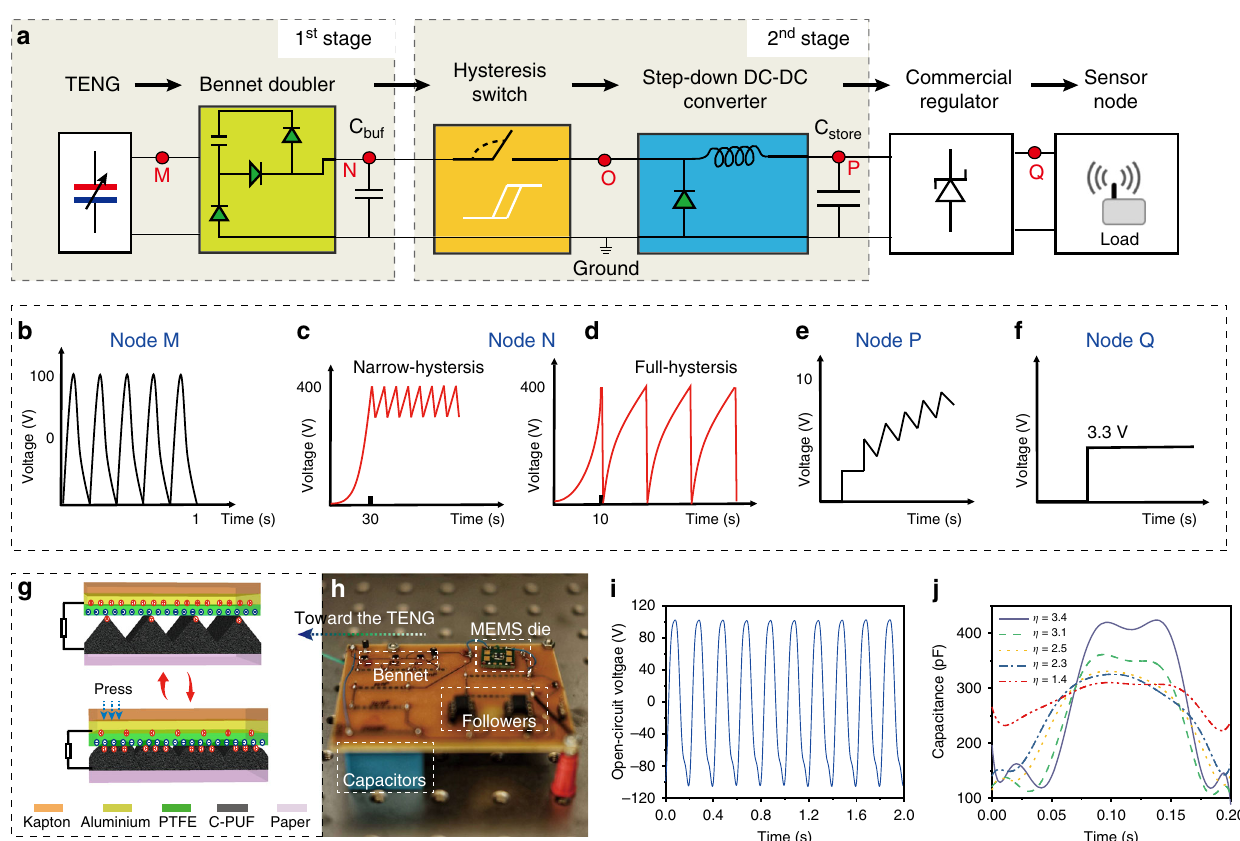
Fig. 1 Schematic and electrical states of the conditioning circuit. a Diagram of the conditioning system. Shapes and orders of magnitude of the voltages ( b ) generated by the triboelectric nanogenerator (TENG) used in the experiments, across the buffer capacitor with a narrow-hysteresis switch ( c ) or a full- hysteresis switch ( d ), e across C store , f at the output of the regulator. g Schematic and operation principle of the TENG 44 constructed with Kapton, Polytetra fl uoroethylene (PTFE), Aluminium, conductive polyurethane foam (C-PUF) and paper. h The printed-circuit-board of the circuit. i Open circuit voltage of the TENG. j Capacitance variations of the TENG under different tapping forces, from 2 N to 10 N with 2 N per step, corresponding to different capacitance variations ( η ). Source data are provided as a Source data fi